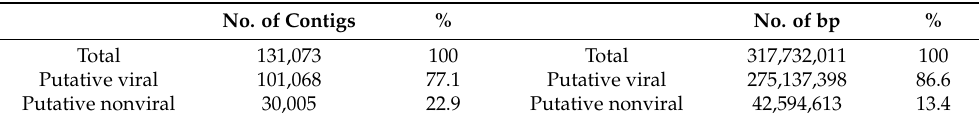
Table 1. Data of total contigs and total Mbp from the merged 11 assemblies. Putative viral and putative nonviral contigs and Mbp were identified by VirSorter2 and are visualized for each assembly in Figure 1. Data for the contig and Mbp distributions of individual assemblies are presented in Tables S3 and S4 (Supplementary Materials). Assembly 12 is